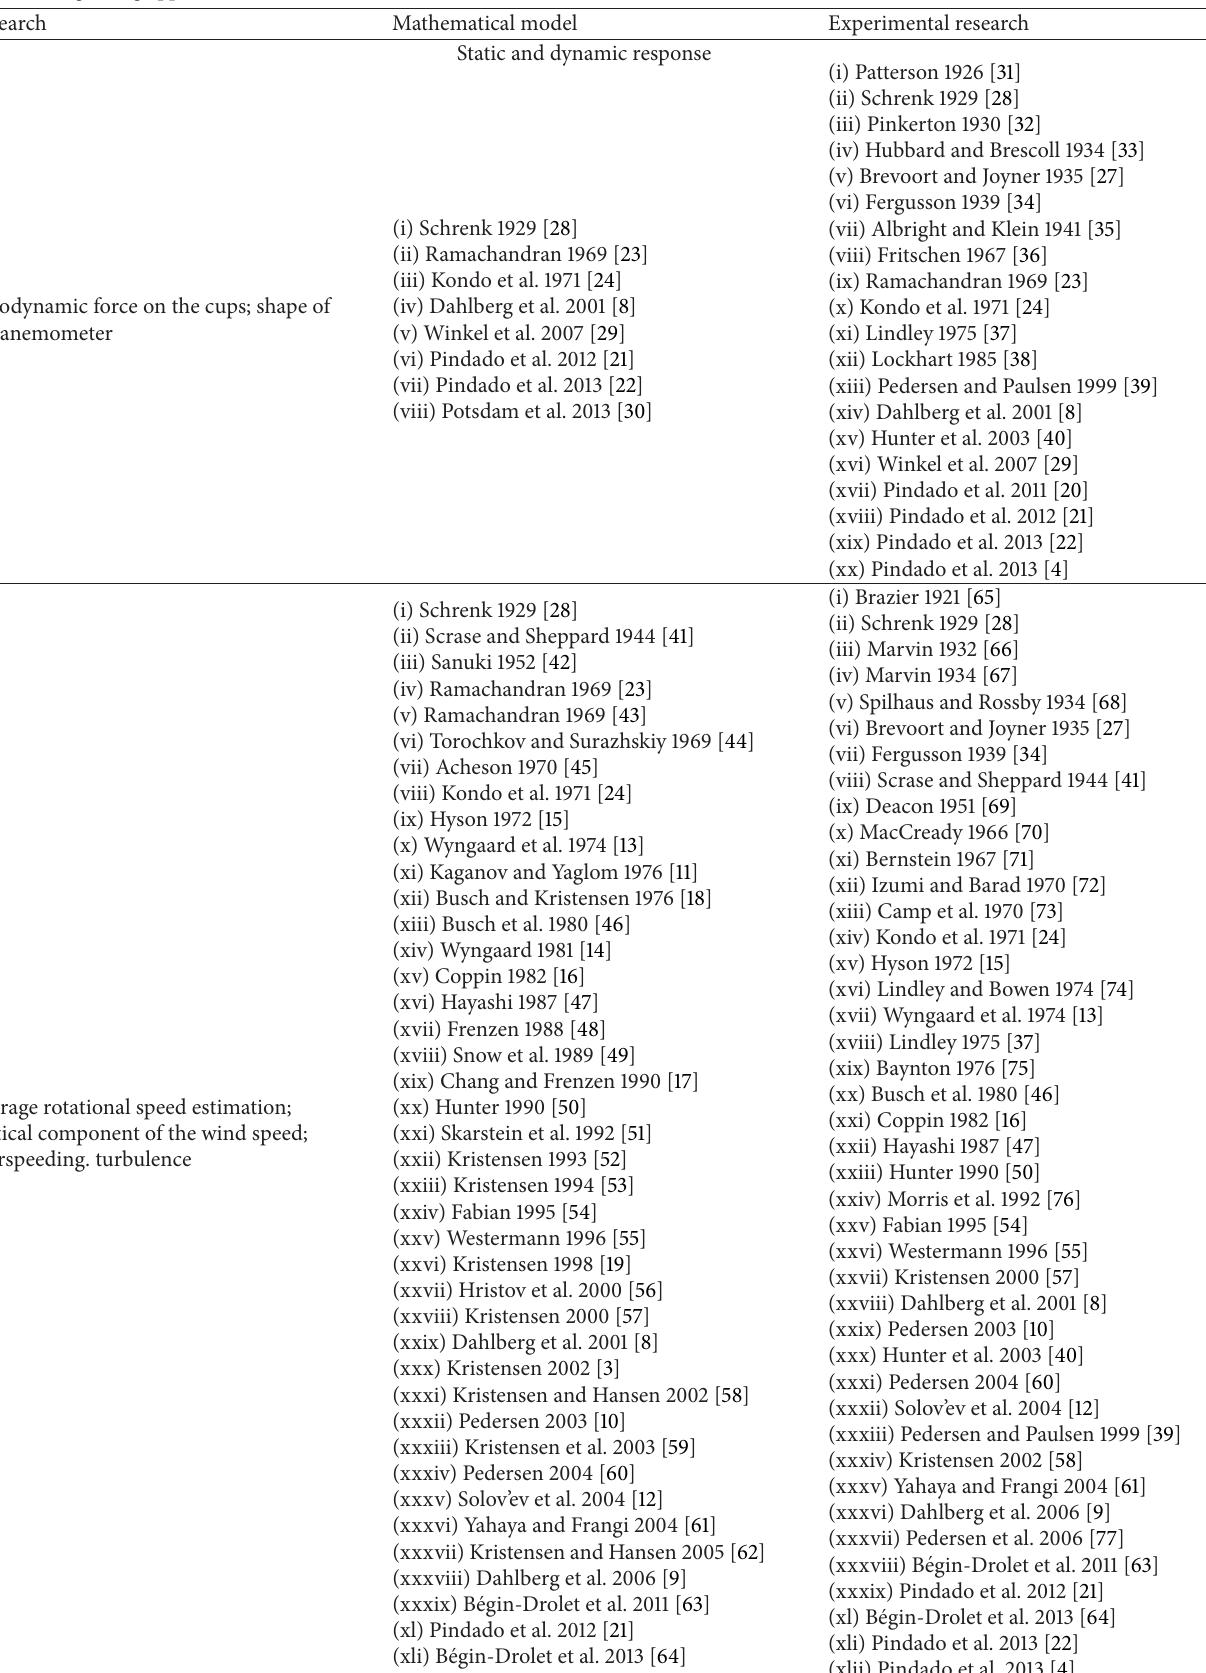
Table 1: Research carried out on cup anemometer behavior/performances. References classified by areas of study and research. Some references regarding applications have also been